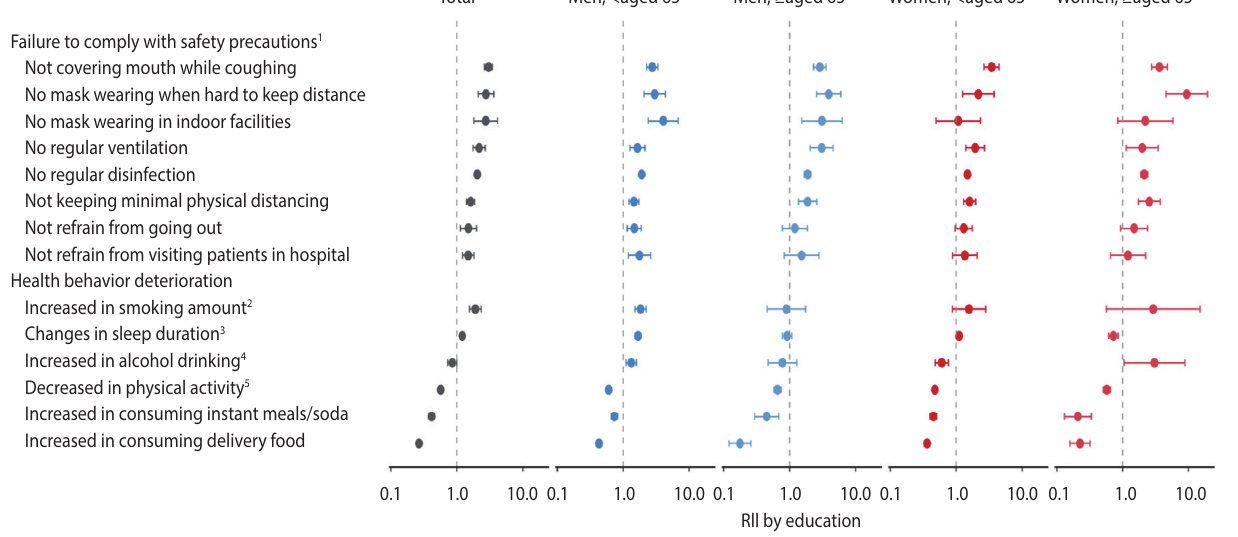
Figure 1. Relative index of inequality (RII) by education levels for failure to comply with coronavirus disease 2019 (COVID-19) safety precau- tions and health behavior deterioration in the total population and by gender and age. Questions were sorted by descending order of RII values in the total population analysis. 1 Adjusted for quarantine isolation experience due to COVID-19 infection and recent experience of fever/coughing. 2 Adjusted for smoking status (current/past). 3 Adjusted for sleep duration. 4 Adjusted for alcohol drinking frequencies. 5 Ad- justed for moderate physical activity